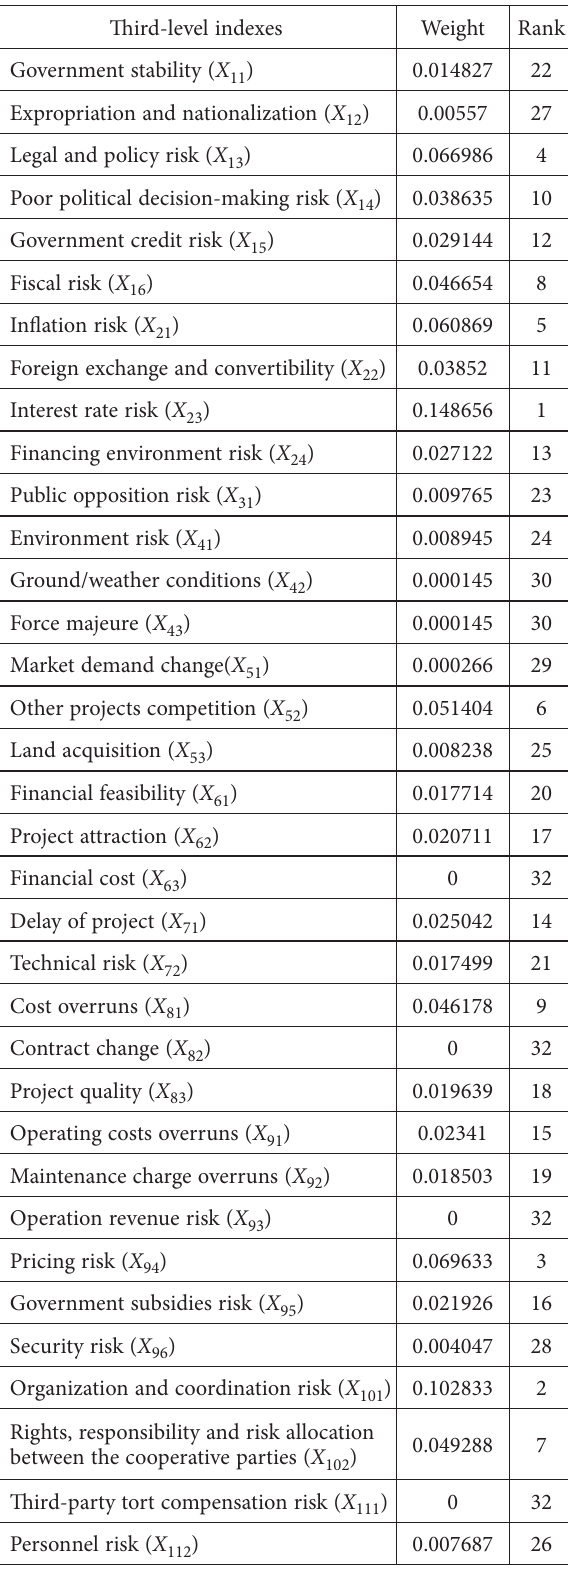
Table 9. Priorities of risk